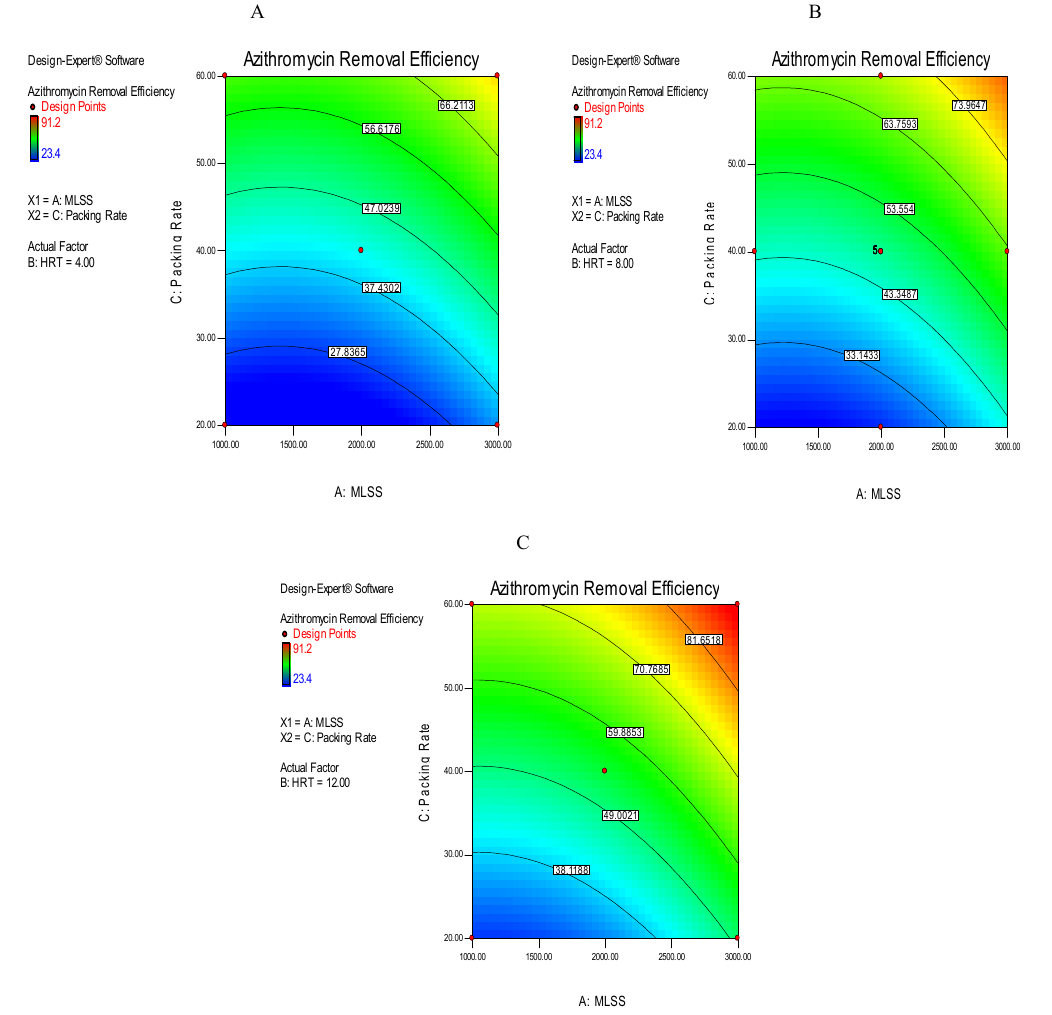
Fig. 3. Removal efficiency of azithromycin with HRT at A) 4 hours, B) 8 hours, and C) 12 hours using combined system of UV/H 2 O 2 process and MBBR